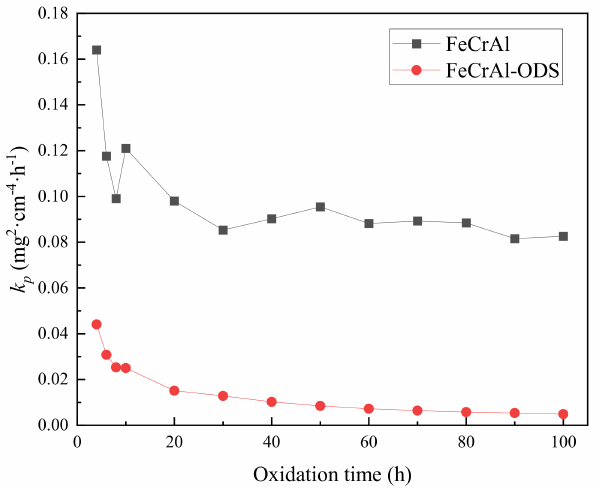
Figure 7. Parabolic oxidation rate k p with time